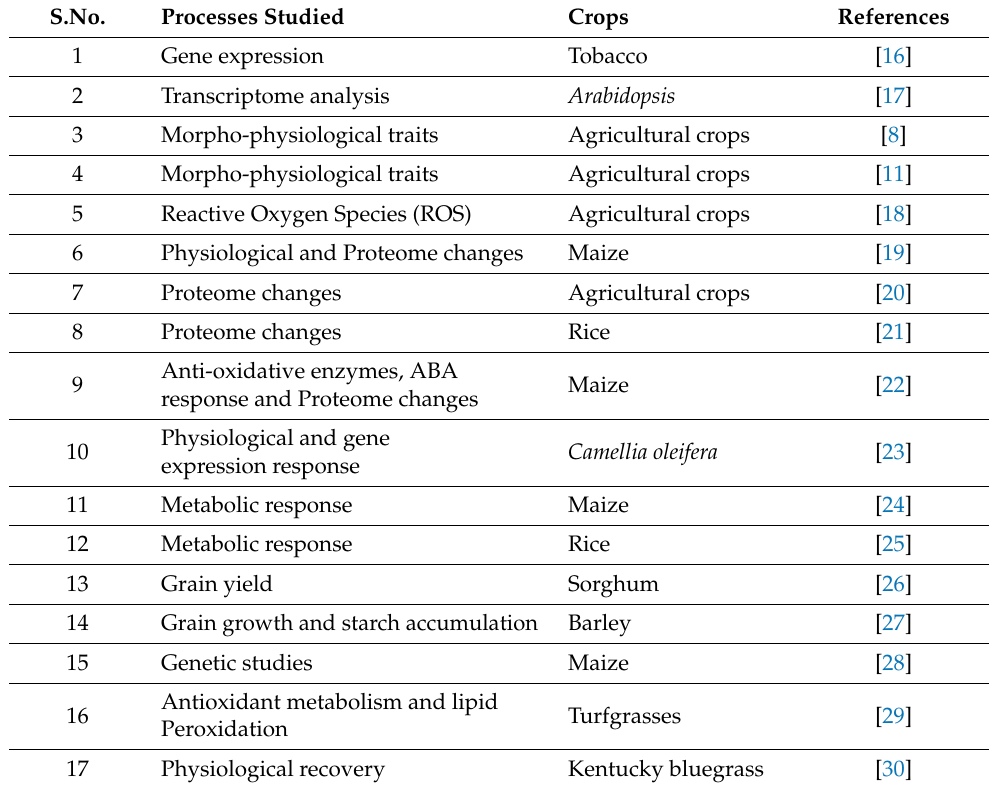
Table 1. Representative examples showing the physiological and molecular processes studied in plants in response to combined high temperature and drought stress (HT+D). S.No. Processes Studied